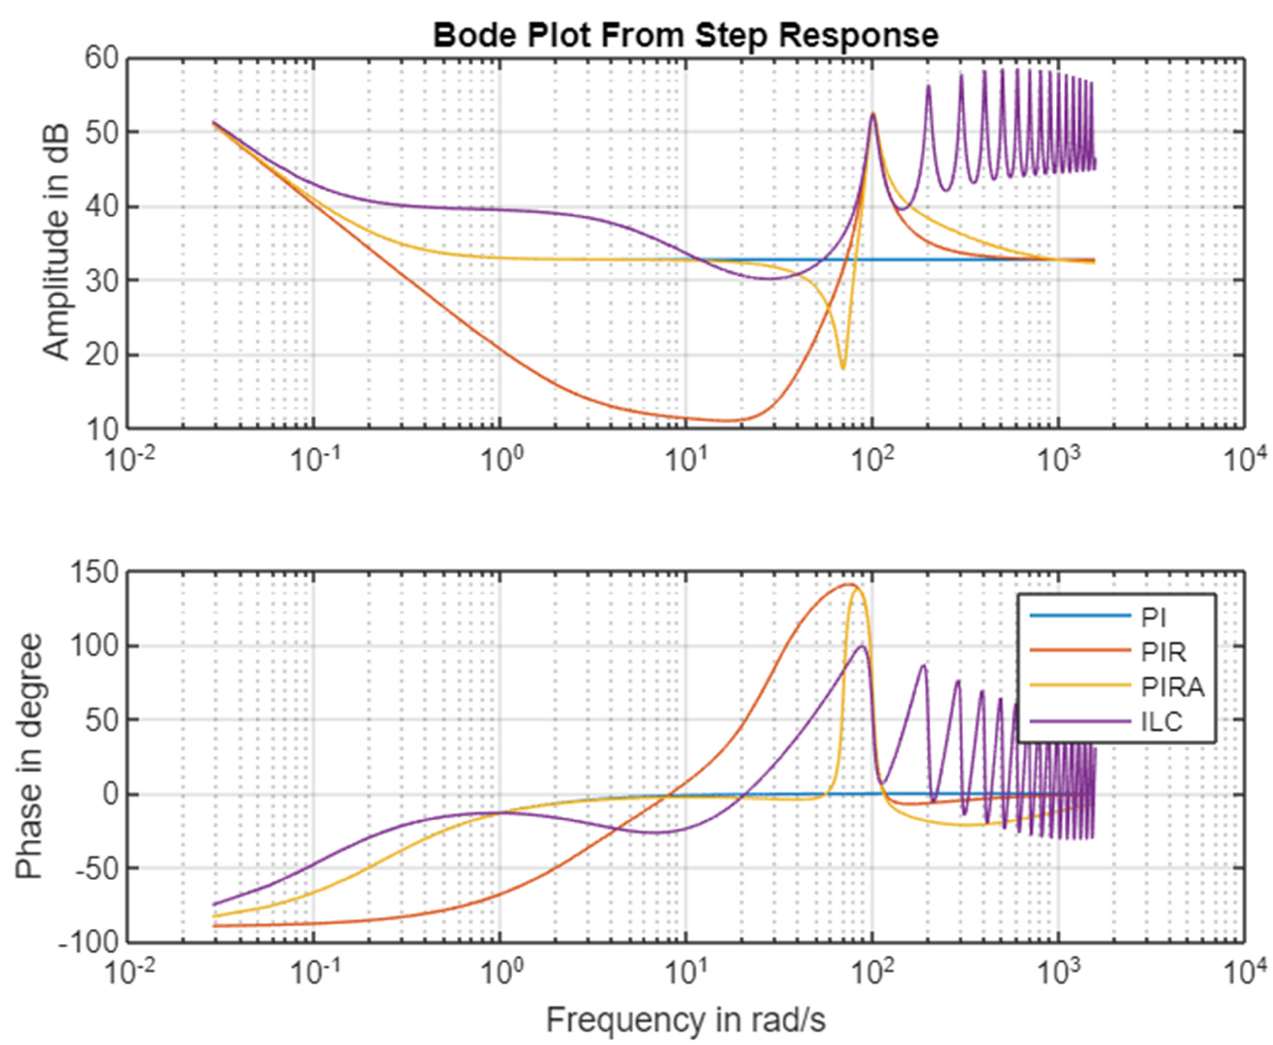
Figure 8. Comparing the Bode Plot of the four controllers. To avoid this, it may be appropriate to apply a low pass filter to the reference